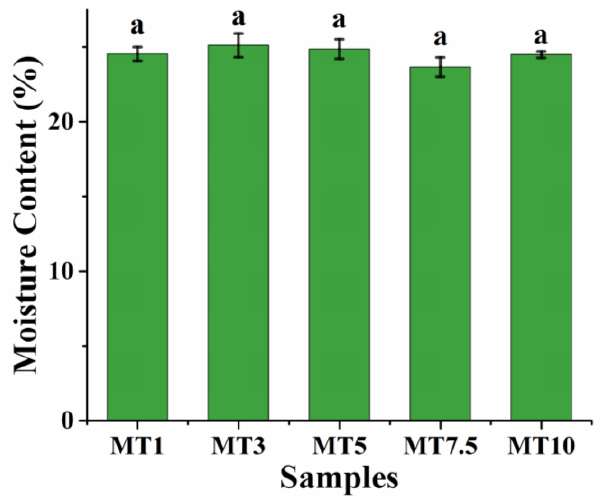
Figure 2. Moisture content profile of the cookie dough. Error bars represent the standard deviation of three replicates. For each chart, not sharing the same letter(s) are significantly different by Tukey HSD test.